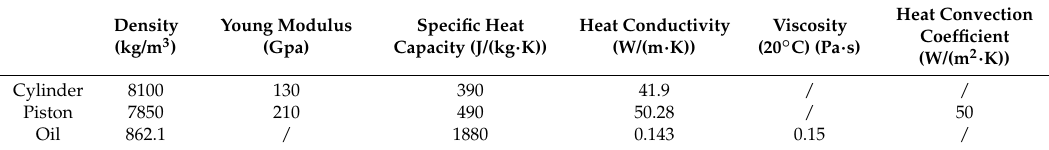
Table 2. Material